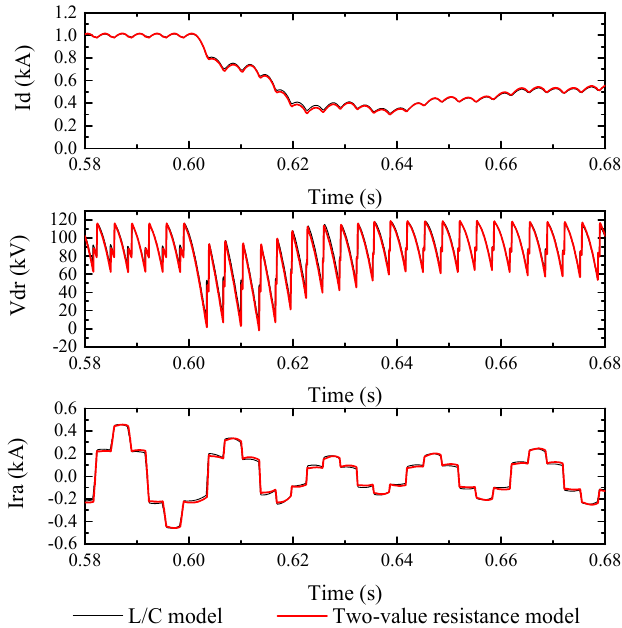
Figure 11. Response of system to the current order is changed from 1.0 kA to 0.5 kA. ( Top ) rectifier DC current, ( middle ) rectifier DC voltage, ( bottom ) rectifier AC current (Case 1).